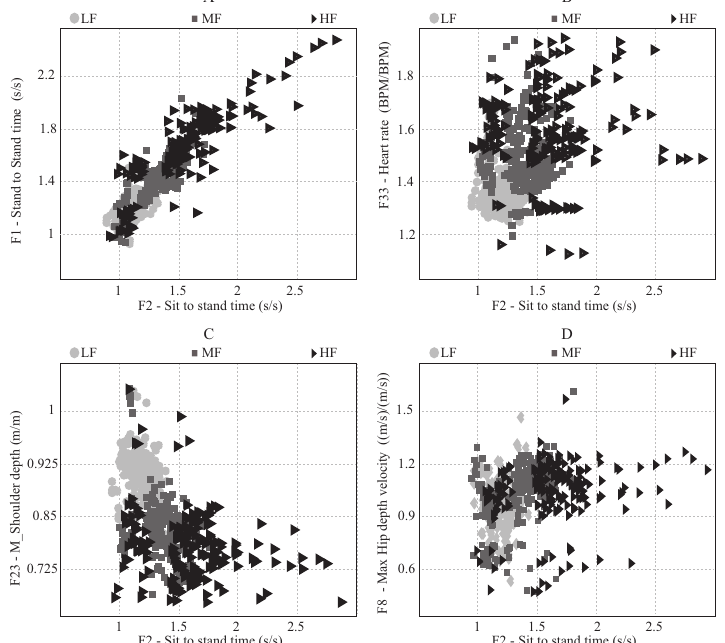
Figure 13. Features scatter graphs regarding the stand-to-stand time, ( A ) stand-to-stand time vs. sit-to-stand time, ( B ) sit-to-stand time vs. heart rate, ( C ) sit-to-stand time range vs. M_shoulder depth range, and ( D ) sit-to-stand time vs. M_hip max depth